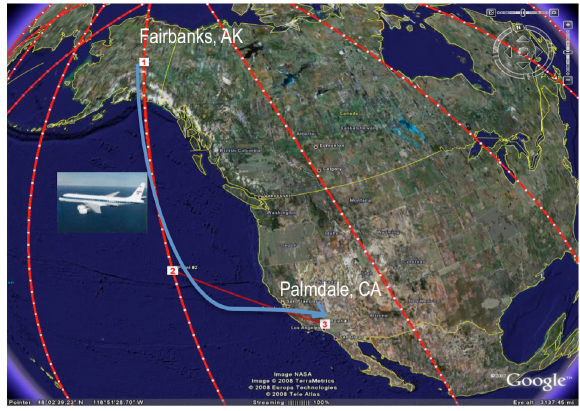
Fig. 1. April 2008 MODIS fire count. Figure 1: April 2008 MODIS fire count